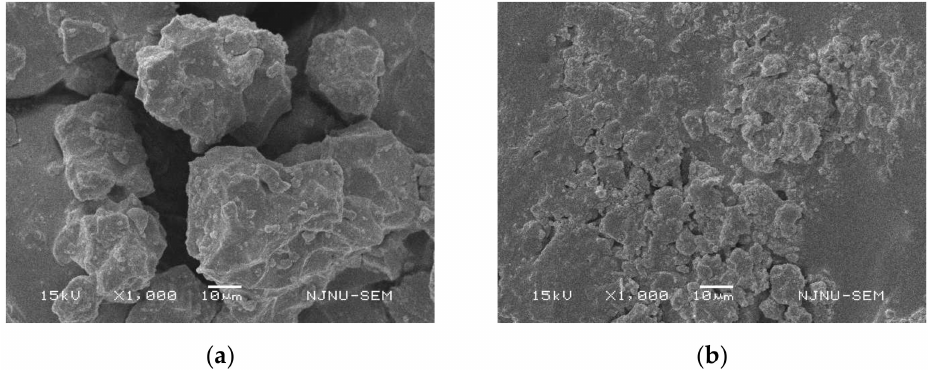
Figure 11. Microscopic photographs of asphalt mortar: ( a ) Mixed with limestone mineral powder; ( b ) Mixed with MIRP.